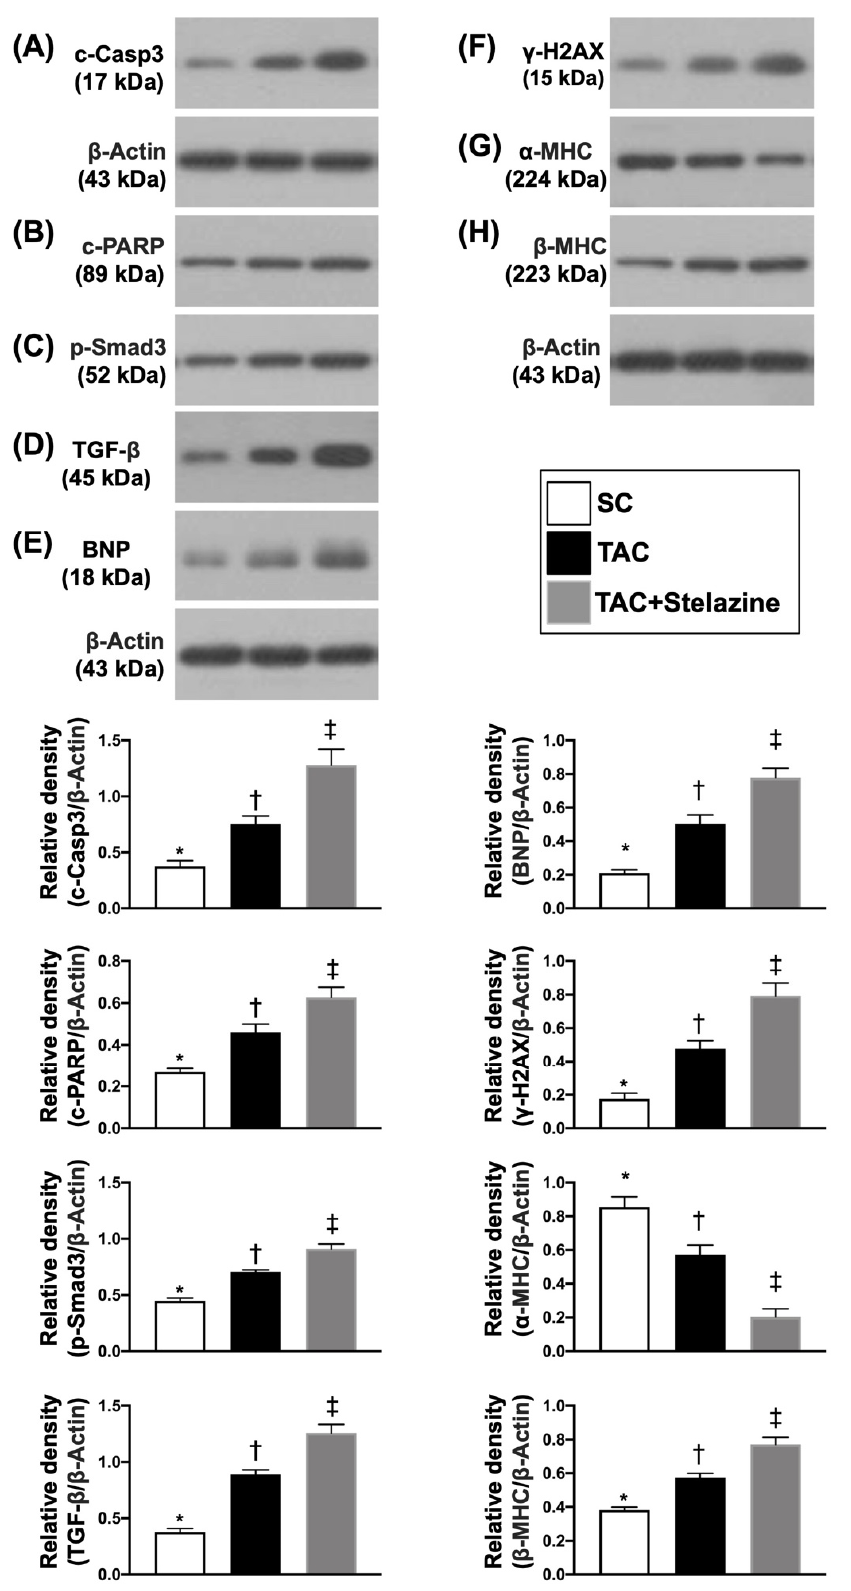
Figure 9. Protein expressions of apoptotic, fibrotic, pressure-overload/heart-failure, mitochondrial/DNA-damaged biomarkers in LV myocardium by day 28 after TAC procedure. ( A ) Protein expression of cleaved caspase 3 (c-Casp3), * vs. other groups with different symbols (†, ‡), p < 0.0001. ( B ) Protein expression